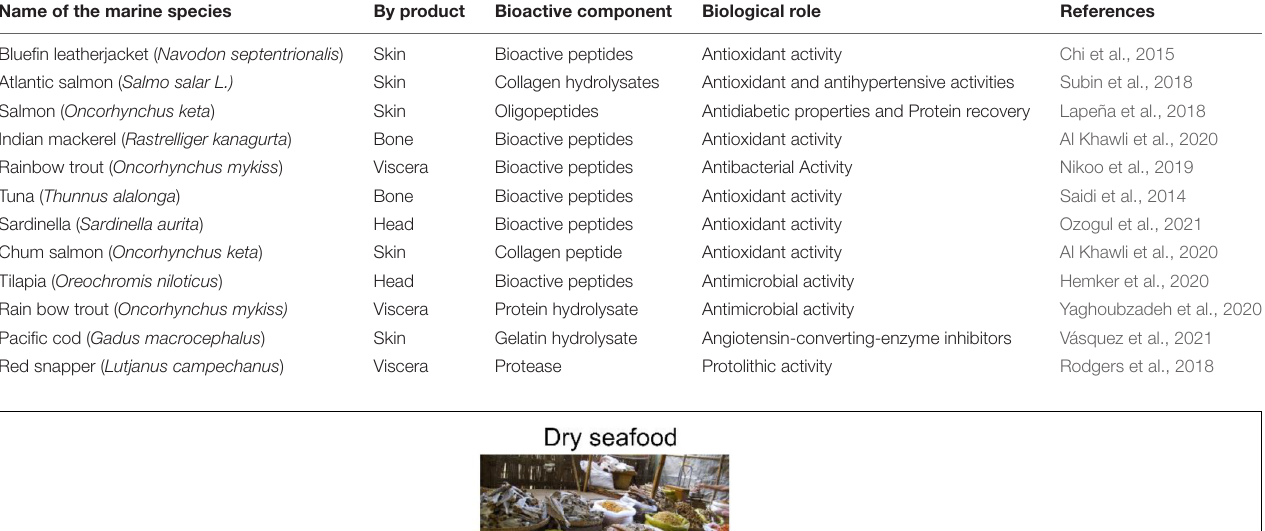
TABLE 5 | Various by-products with biological activities extracted from different species.